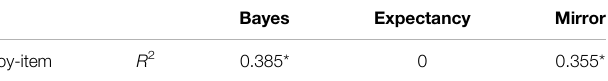
TABLE 13 | Correlations between observed data and model predictions in Experiment 3, by items. * indicates signi fi cance at or below 0.001.